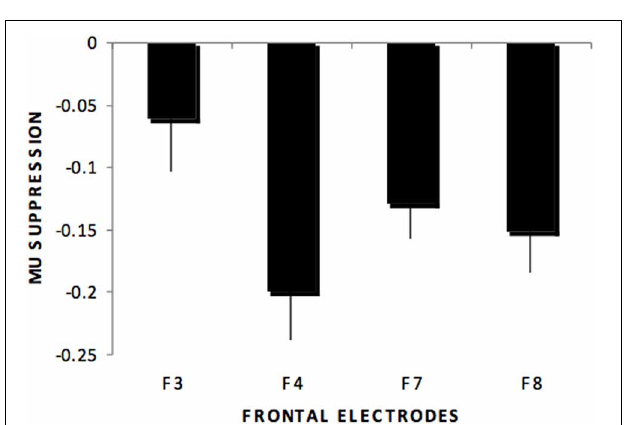
FIGURE 2 | Mu suppression across stimulus type at frontal regions (F3, F4, F7, F8) showing the stimulus type by electrode interaction in which greater mu suppression was recorded over right (F4) compared to left (F3) anterior frontal sites but not over more ventral anterior sites (F7,